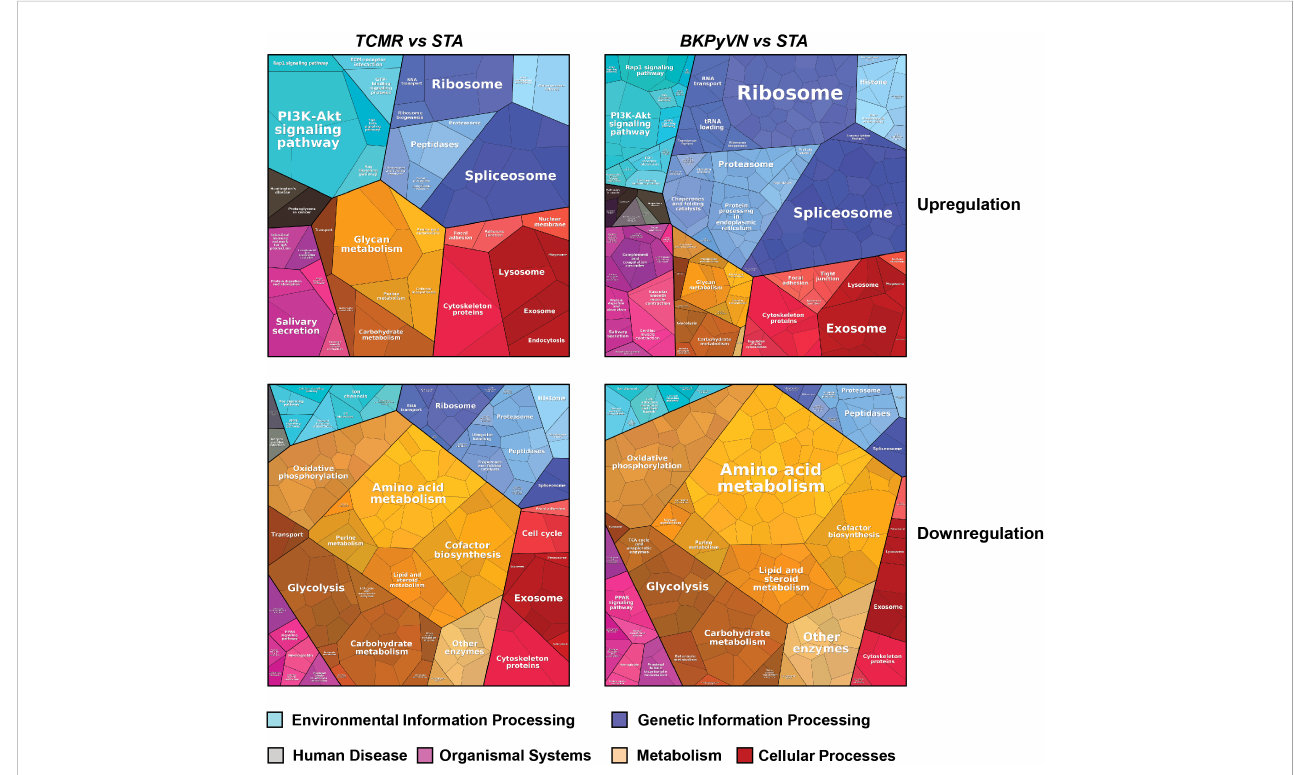
FIGURE 5 Biological classi fi cation of DEPs from label-free quantitative proteome data sets. Treemap of cellular categories altered in disease biopsies in comparison with STA sample illustrated by Proteomaps. The conditions of each disease are marked on the upper side.